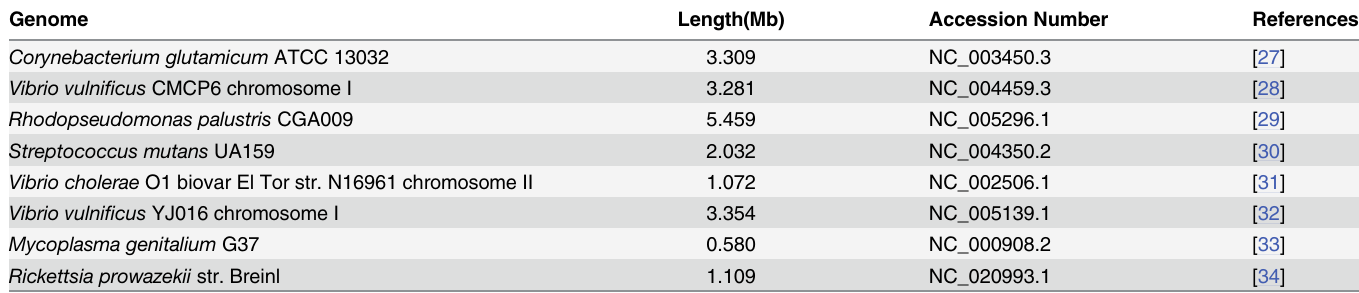
Table 1. Genomes used for testing mean shift and other related